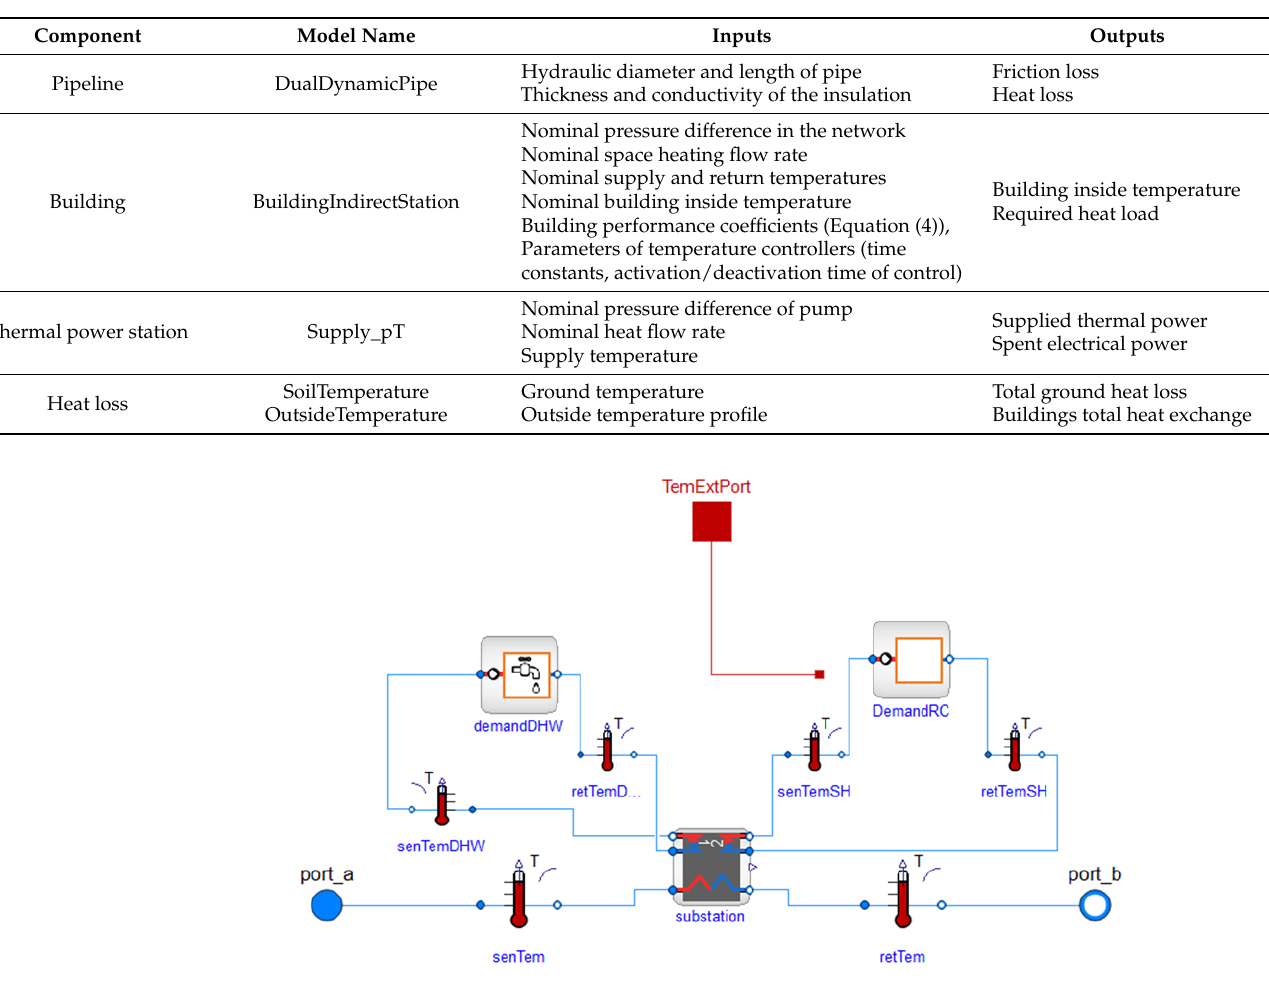
Figure 3. Diagram view of “BuildingIndirectStations” model component in Dymola.